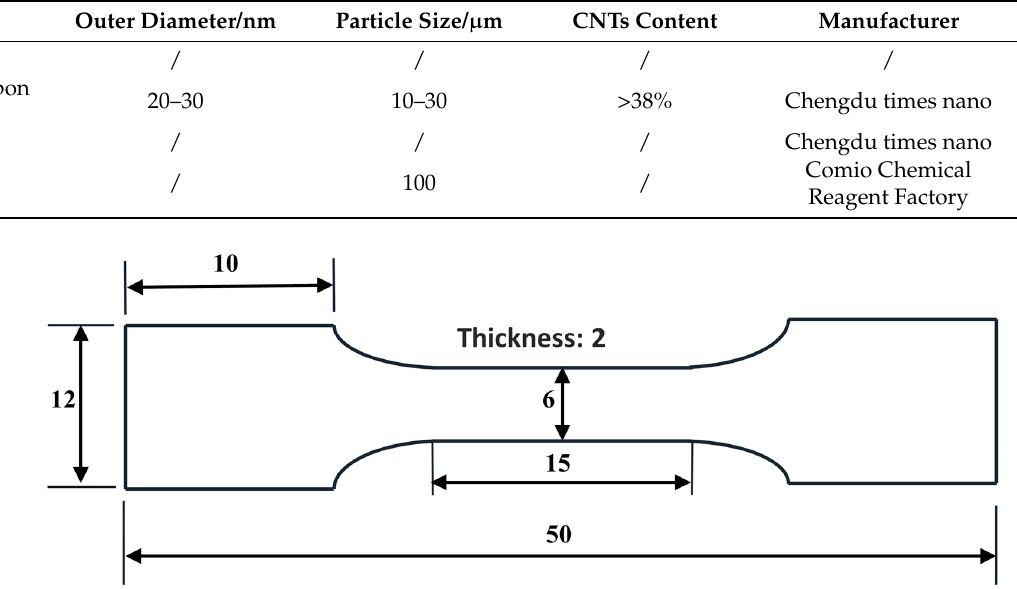
Table 1. Primary experimental materials.